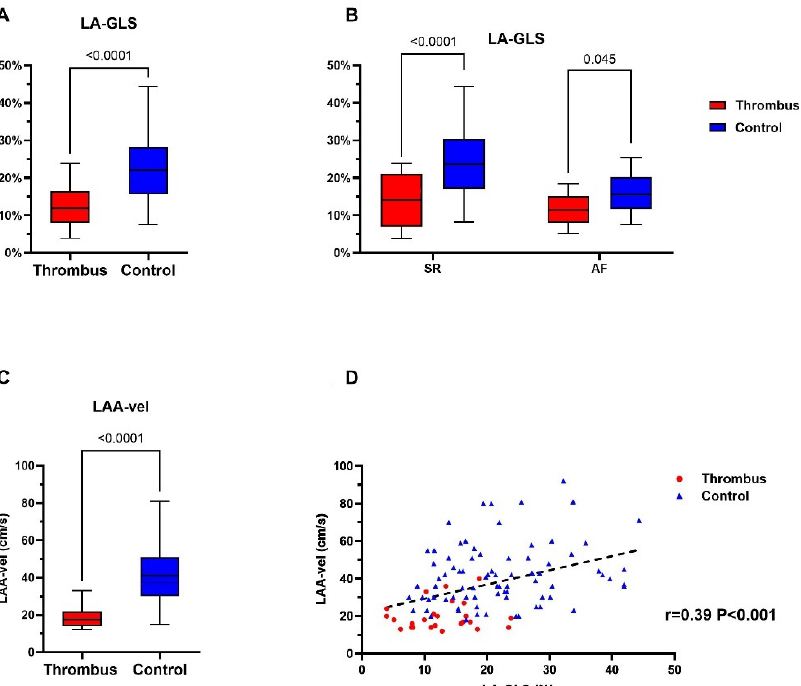
Figure 2. Assessment of echocardiographic parameters for thrombus identification in the thrombus group (red) and control group (blue). ( A , B ) demonstrates the difference in LA-GLS between the thrombus and control group in general and rhythm-specific comparison. ( C ) shows the LAA maximal flow velocity in the thrombus and control group. p value for each comparison is displayed in each figure ( A – C ). ( D ) demonstrates the positive correlation (black dashed line) between LAA-velocity and LA-GLS in individuals of the thrombus- (red) and control-group (blue), respectively. LA-GLS, left atrial global longitudinal strain; LAA, left atrial appendage; LAA-vel, left atrial appendage maximal flow velocity.